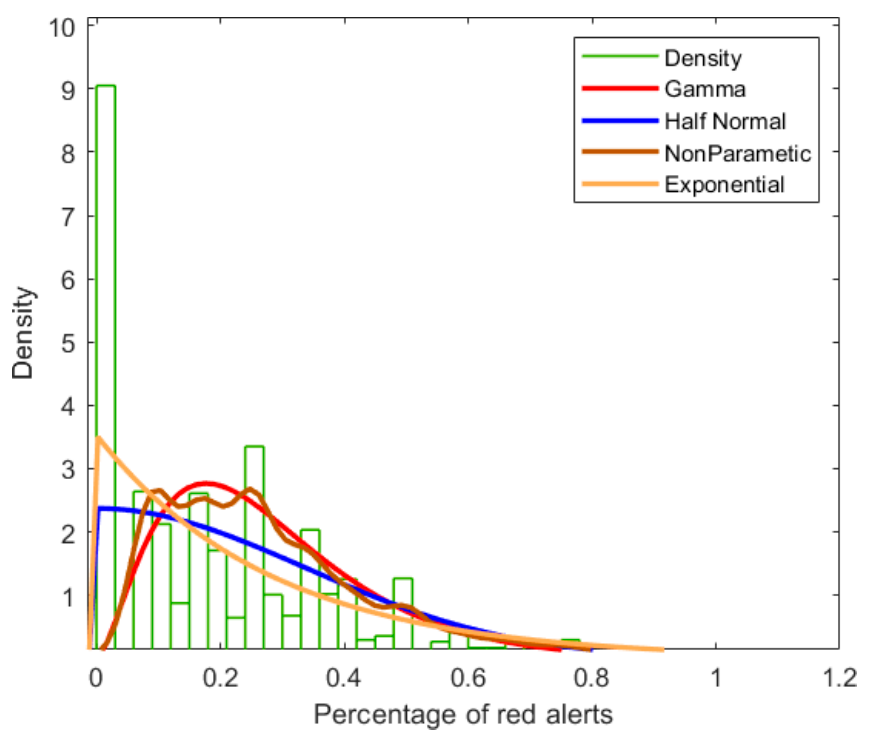
Figure 3. Percentage of high-readings in three-day prediction windows to be predicted (OUH dataset), compared to different distributions.